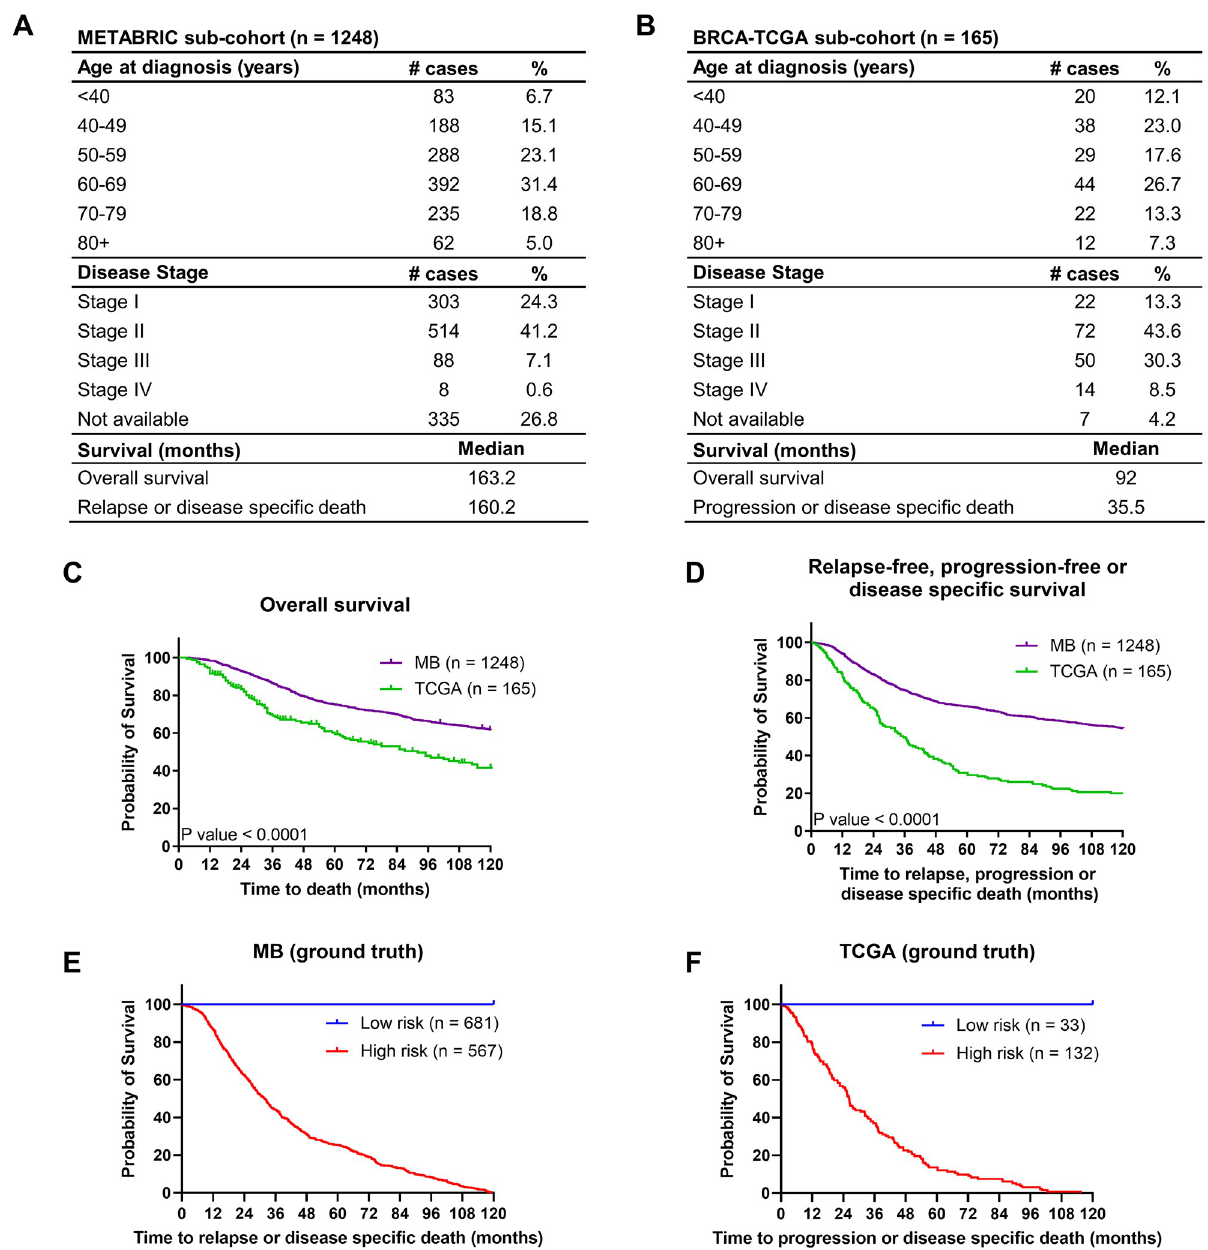
Fig 1. MB and TCGA patient demographics and survival. ( A ) Patient demographics of the MB subcohort. ( B ) Patient demographics of the TCGA subcohort. ( C ) Overall and ( D ) relapse-free, progression-free or disease specific survival of the MB and TCGA cohorts. ( E ) Kaplan Meier curves comparing low vs high risk patients of the MB and ( F ) the TCGA